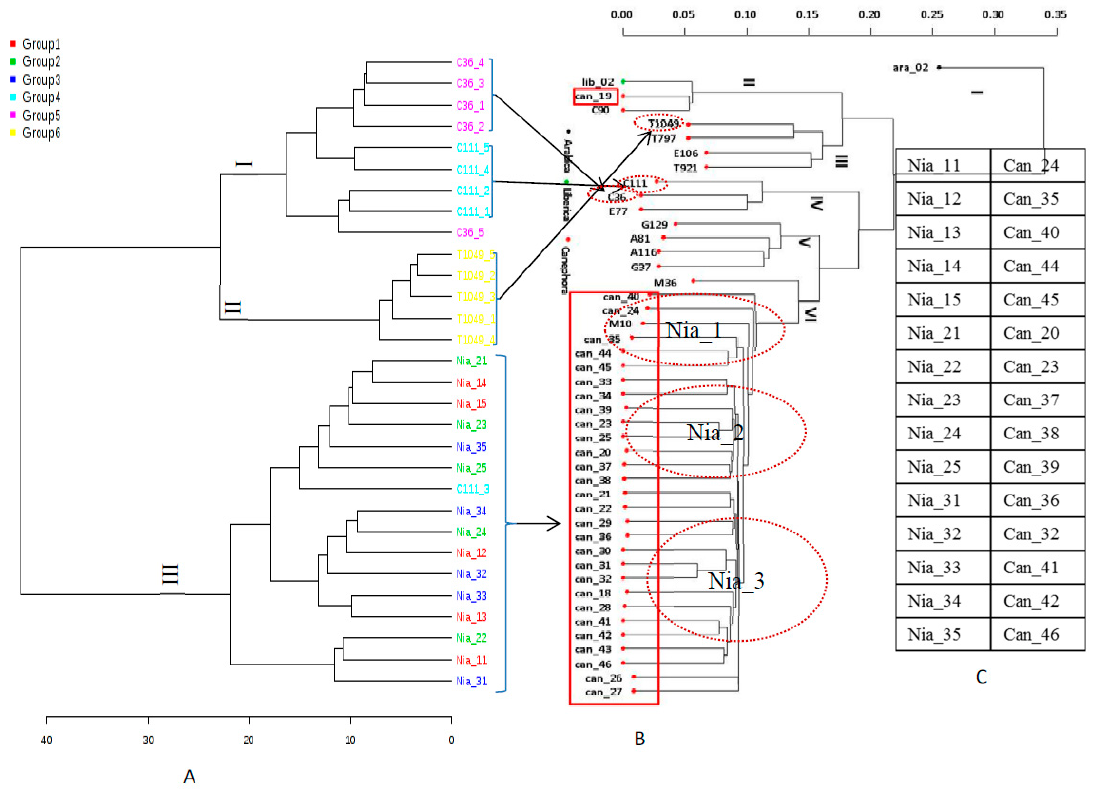
Figure 5. Comparing the metabolite profiles and Single Nucleotide Polymorphism (SNP) diversity of C canephora . ( A ) Hierarchical clustering of the metabolomics data derived from 30 coffee samples. ( B ) Hierarchical clustering of Single Nucleotide Polymorphism-Genotype-By-Sequencing data derived from 47 coffee samples, including those used in the metabolomics analysis. Dotted red circles denote genotypes used for metabolomics analysis. The red rectangular box contains the ‘Niaouli’ genotypes. ( C ) This table matches the ‘Niaouli’ genotypes in ( A ) to those in ( B ), where Nia_11 is the same as Can_24.